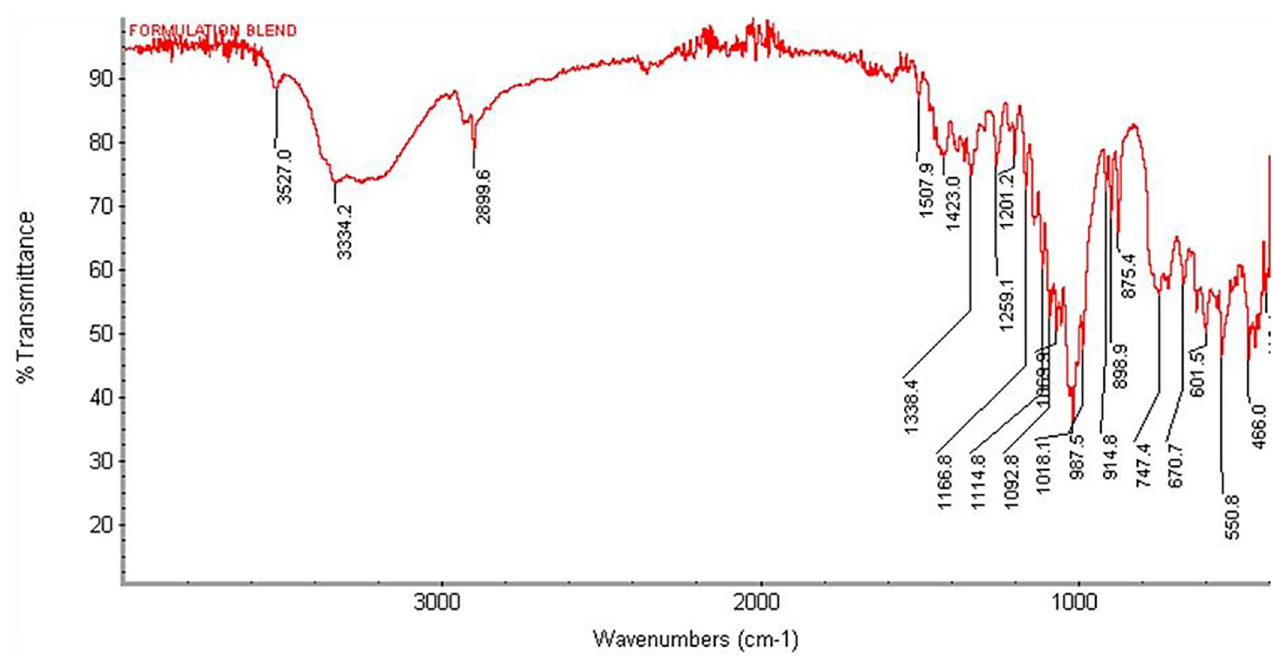
FIGURA 4 - FTIR Spectrum of formulation blend containing diclofenac sodium and Mulva neglecta